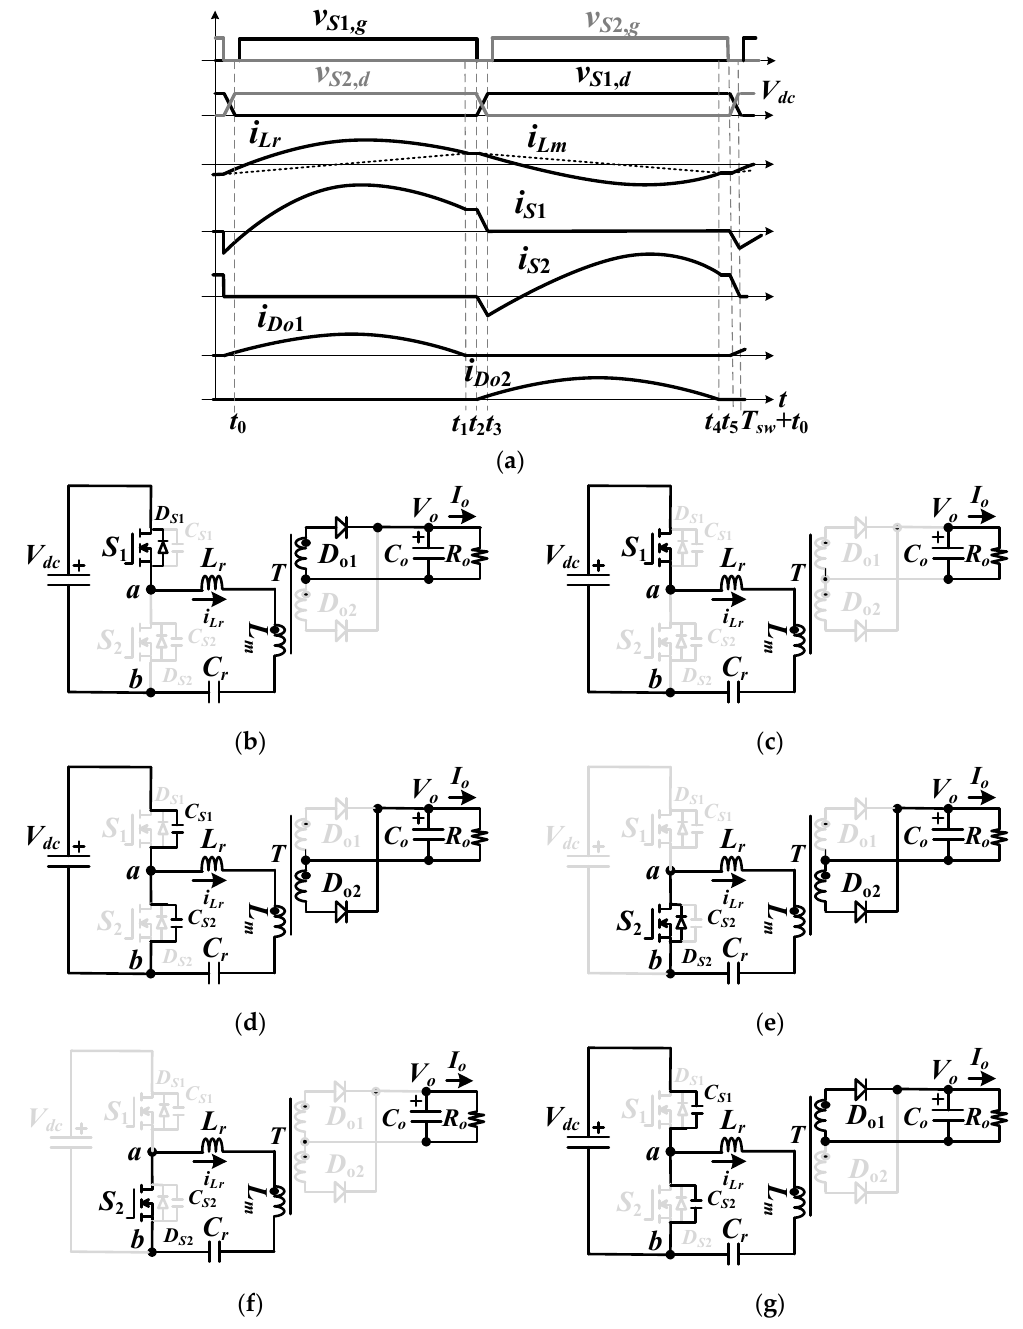
Figure 5. Circuit operations of resonant converter ( a ) PWM signals ( b ) mode 1 equivalent circuit ( c ) mode 2 equivalent circuit ( d ) mode 3 equivalent circuit ( e ) mode 4 equivalent circuit ( f ) mode 5 equivalent circuit ( g ) mode 6 equivalent